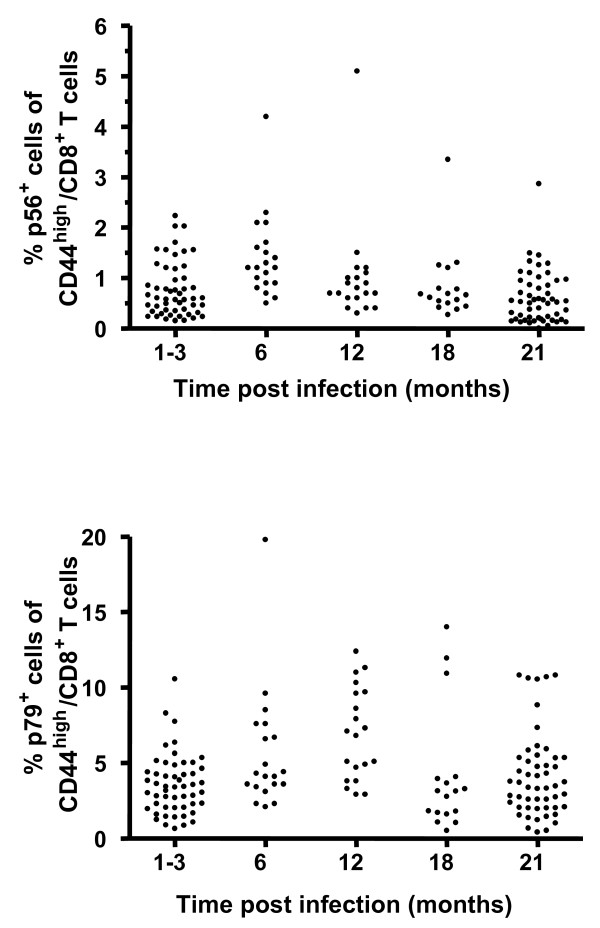
Virus-specific CD8 T cell numbers are maintained with age. Mice were bled at various times following γHV68 infection and virus specific CD8 T cells were detected using MHC class I tetramer staining and flow cytometry. Symbols represent the frequency of ORF6487-495 (p56, upper panel) and ORF61524-531 (p79, lower panel) specific cells among CD44high CD8+ T cells found in the peripheral blood of individual mice at the indicated times post infection.